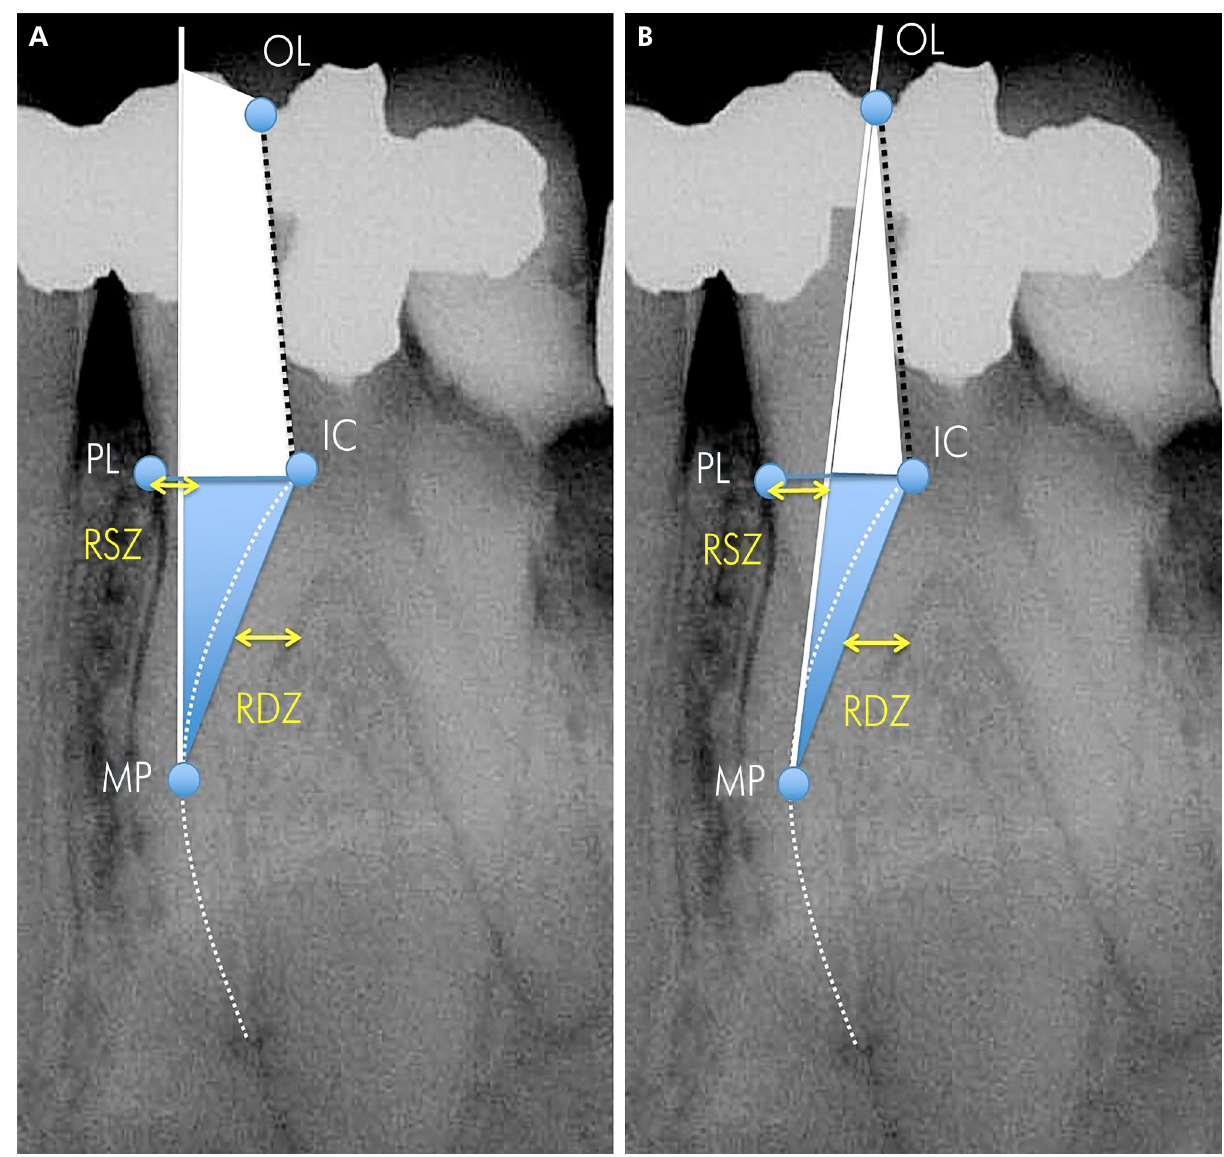
Figure 3. (A) Simulated straight access filing (SF); (B) Simulated conservative filing (CF). Remaining dentin in the safety (RSZ) and danger (RDZ) zones (*yellow arrows), and areas of dentin removal in the root (*blue triangle) and in the crown (*white